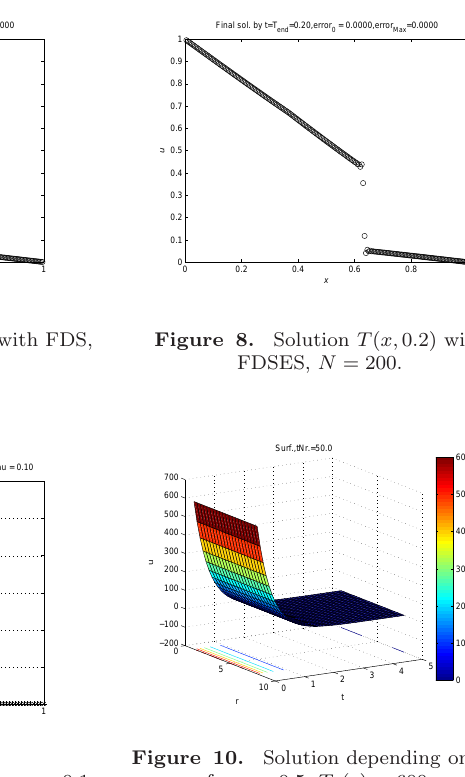
Figure 9. Solution T (0 . 5 ,t ) for τ = 0 . 1, T 0 ( x ) = 600, V 0 ( x ) = − 6000 . 2.